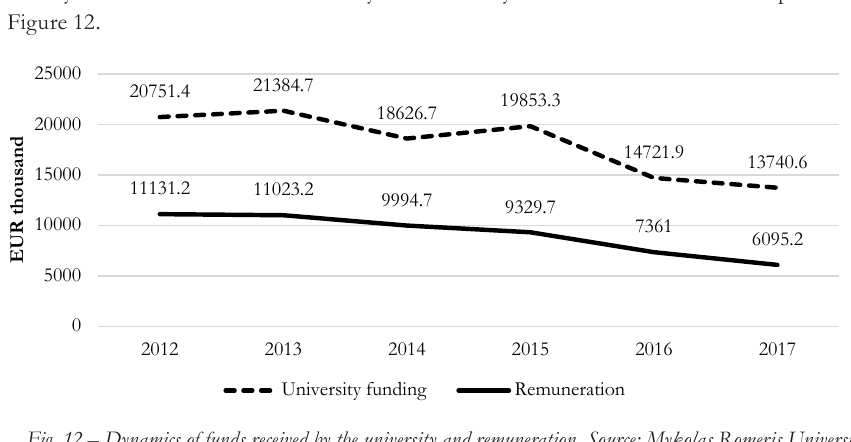
Fig. 12 – Dynamics of funds received by the university and remuneration. Source: Mykolas Romeris University